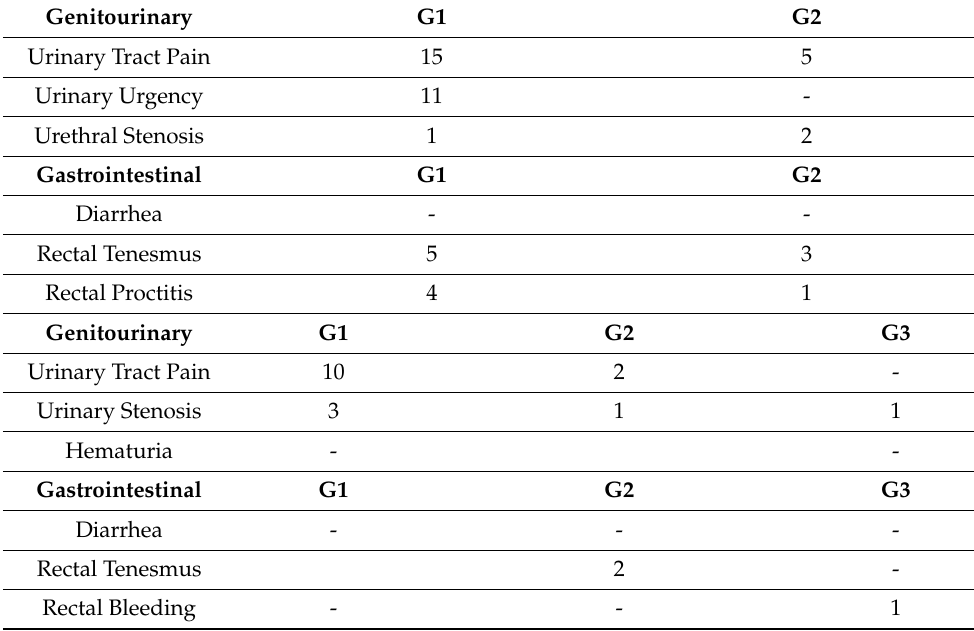
Table 2. Acute (up) and Late (down) toxicity